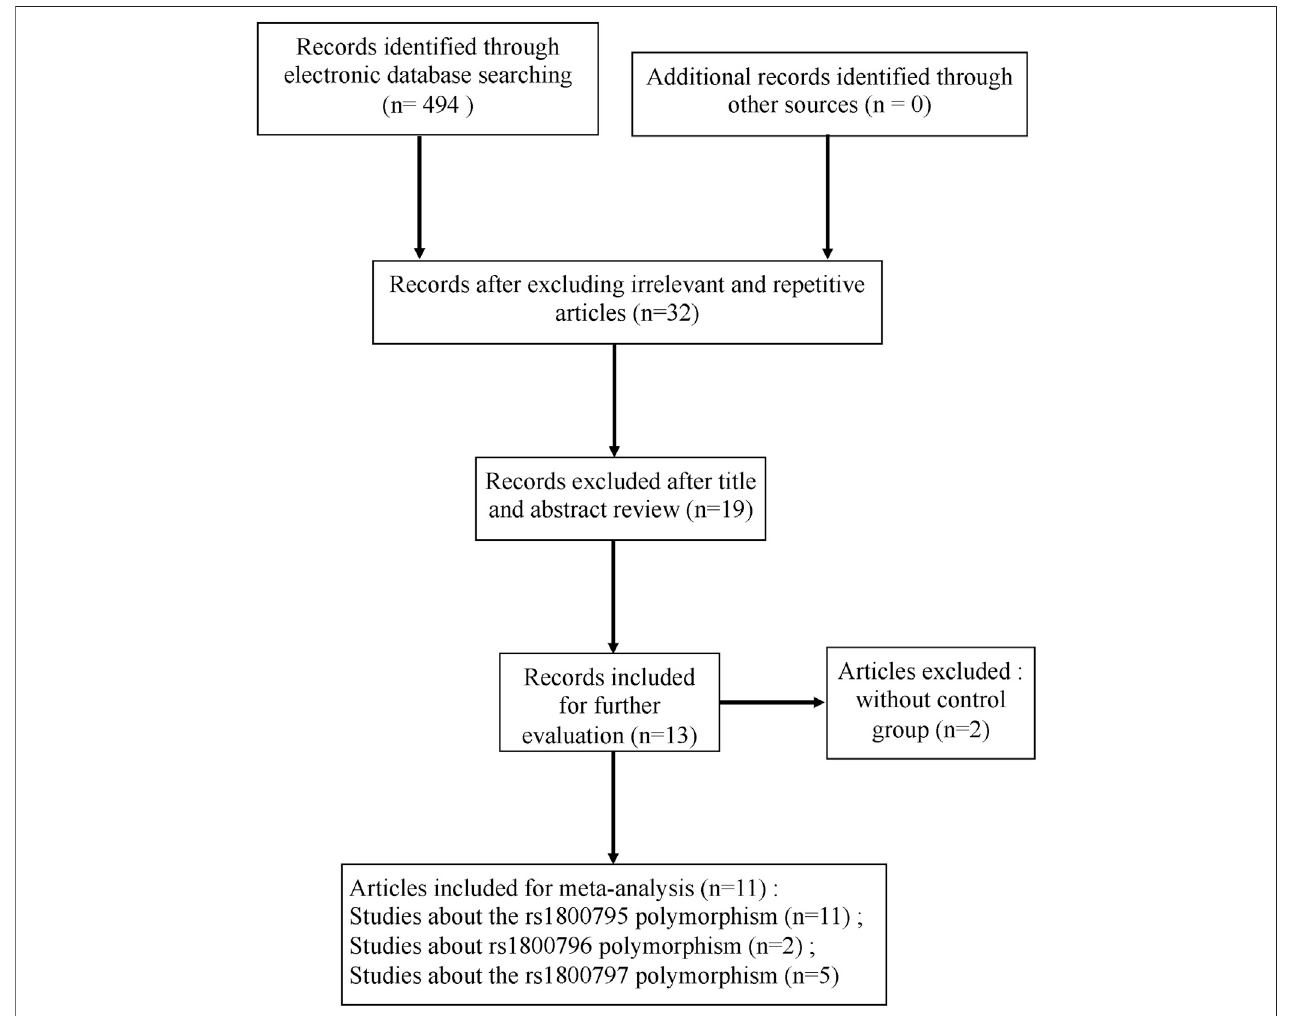
FIGURE 1 | Flow diagram of the study selection